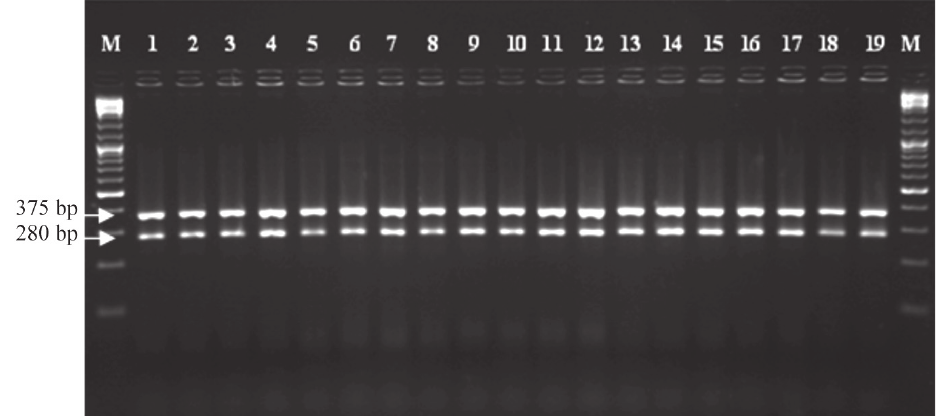
Figure 2. Agarose gel electrophoresis of pmx–PCR products from Ralstonia solanacerum isolates. Lanes: M, DNA molecular marker (Fermentas, cat no. SM 0331); 1, 169; 2, 145; 3, 170; 4, 155; 5, 146; 6, 160; 7, 165; 8, 154; 9, 148; 10, 90; 11, 40; 12, 1; 13, 16; 14, 70; 15, 10; 16, 120; 17, 11; 18, 81; 19,